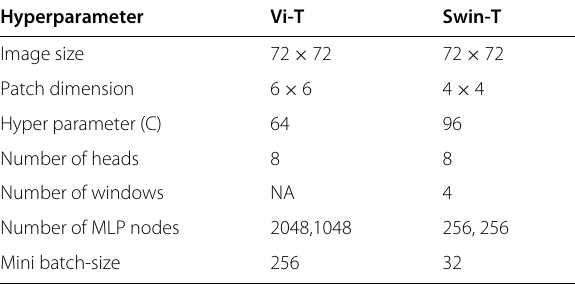
Table 1 Various hyperparameters chosen for Vi-T and Swin-T